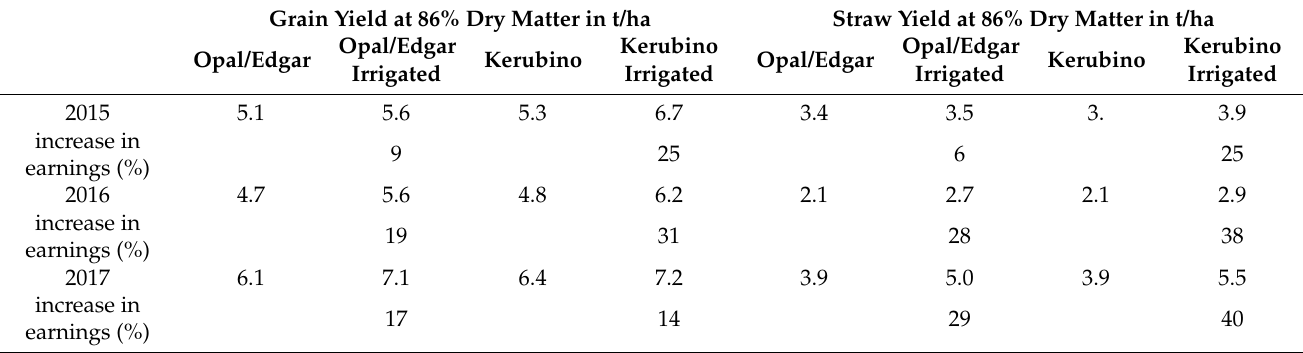
Table 6. Grain and straw yield of winter wheat varieties Opal, Edgar, and Kerubino on irrigated and unirrigated plots. Grain Yield at 86% Dry Matter in